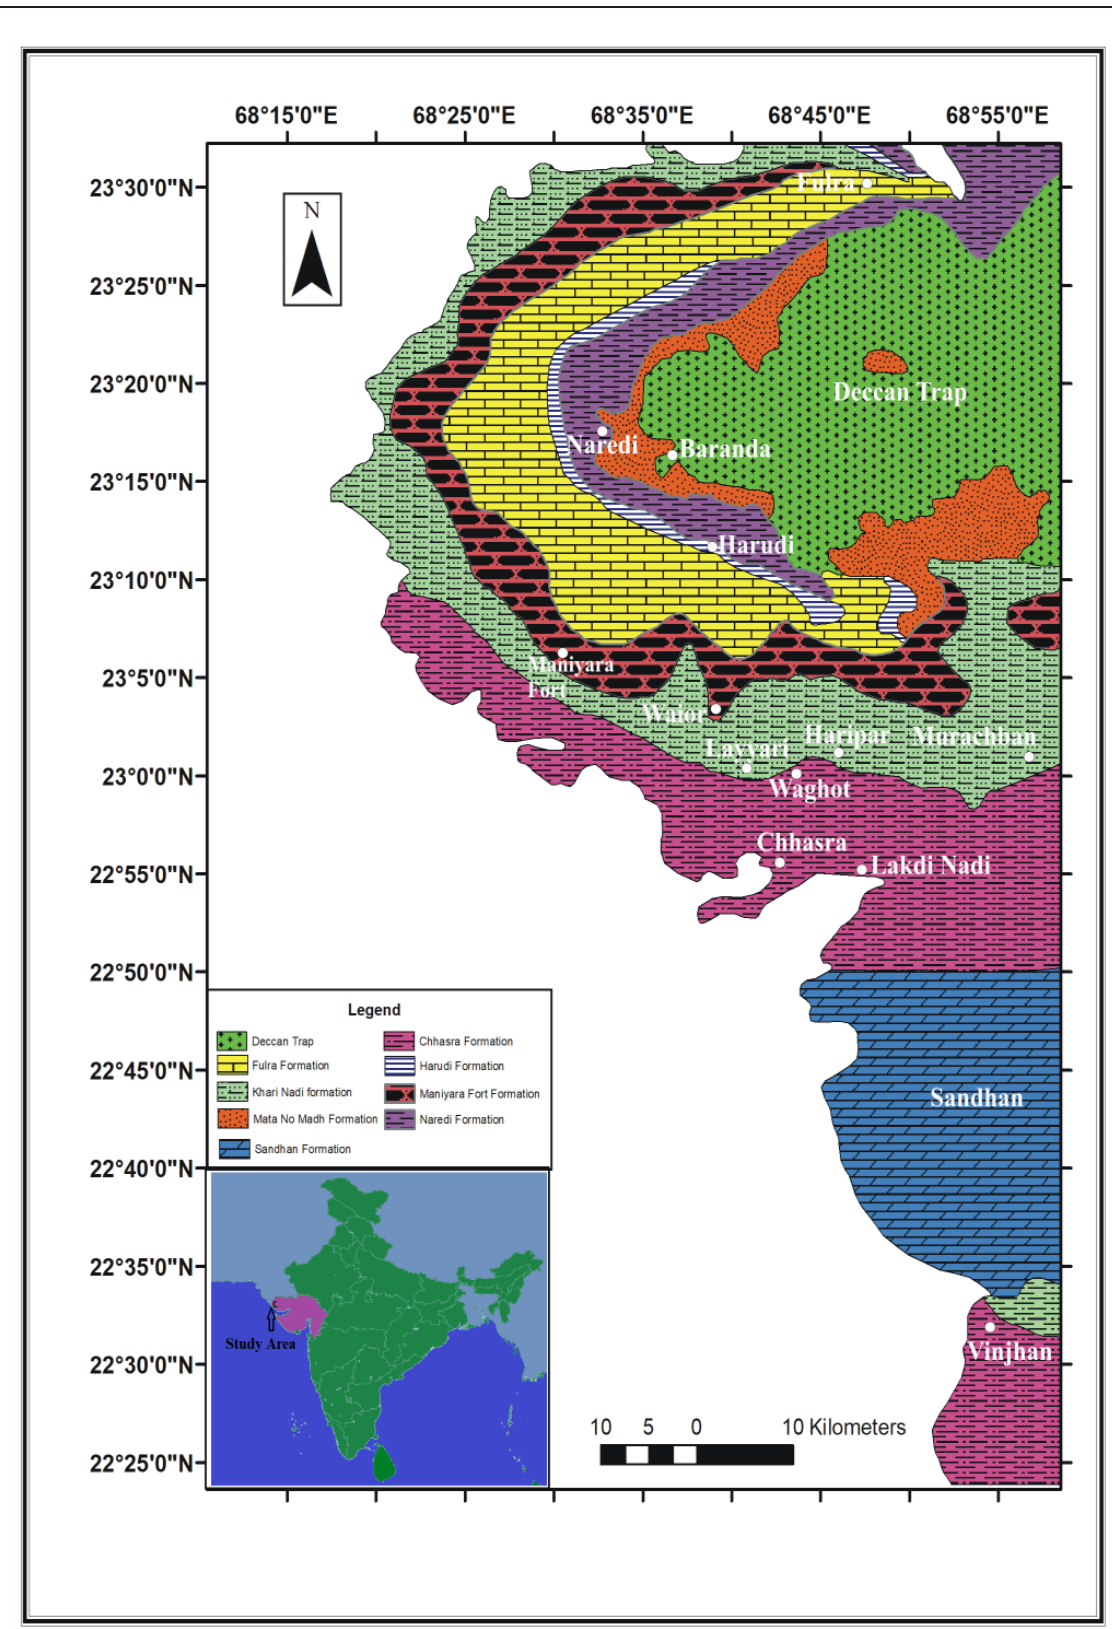
Fig. 1. Geological map of Kachchh (modified after Sonar et al .